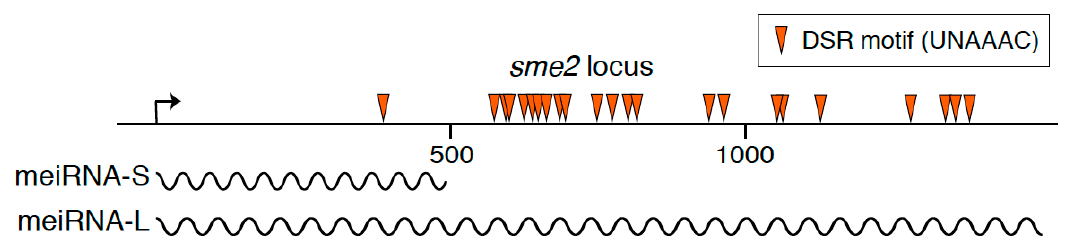
Figure 1. A schematic diagram of the sme2 locus on chromosome II, which encodes meiRNA. Wavy lines indicate two isoforms of the meiRNA transcripts, namely meiRNA-S and meiRNA-L. Arrowheads indicate the determinant of selective removal (DSR) motif, UNAAAC, which is recognized by Mmi1.